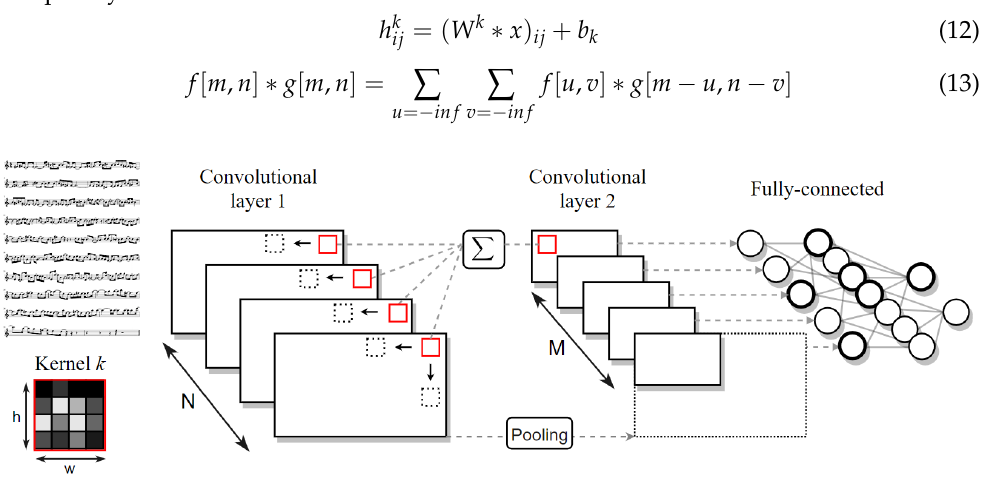
Figure 3. The basic operation process of convolutional neural